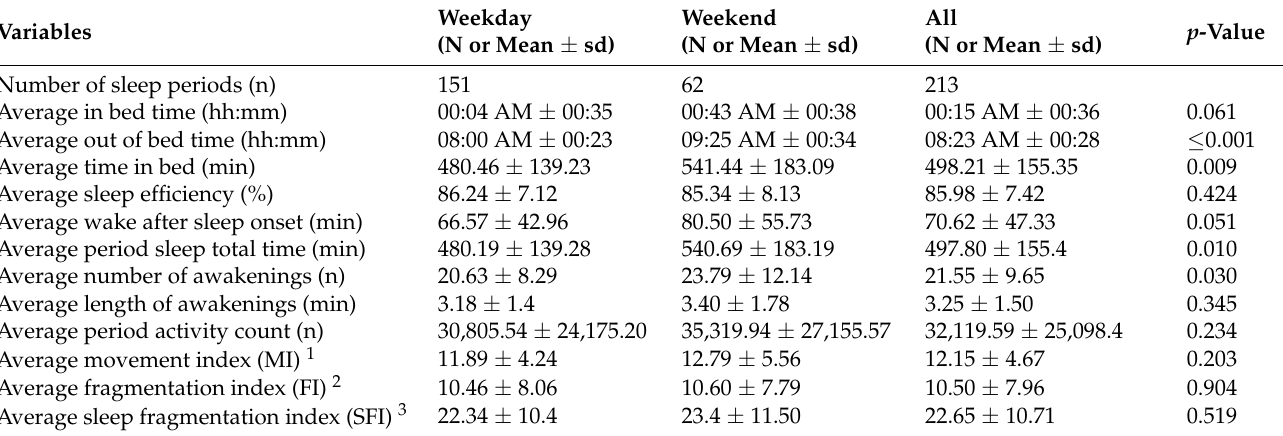
Table 2. Descriptive statistics of sleep (n =